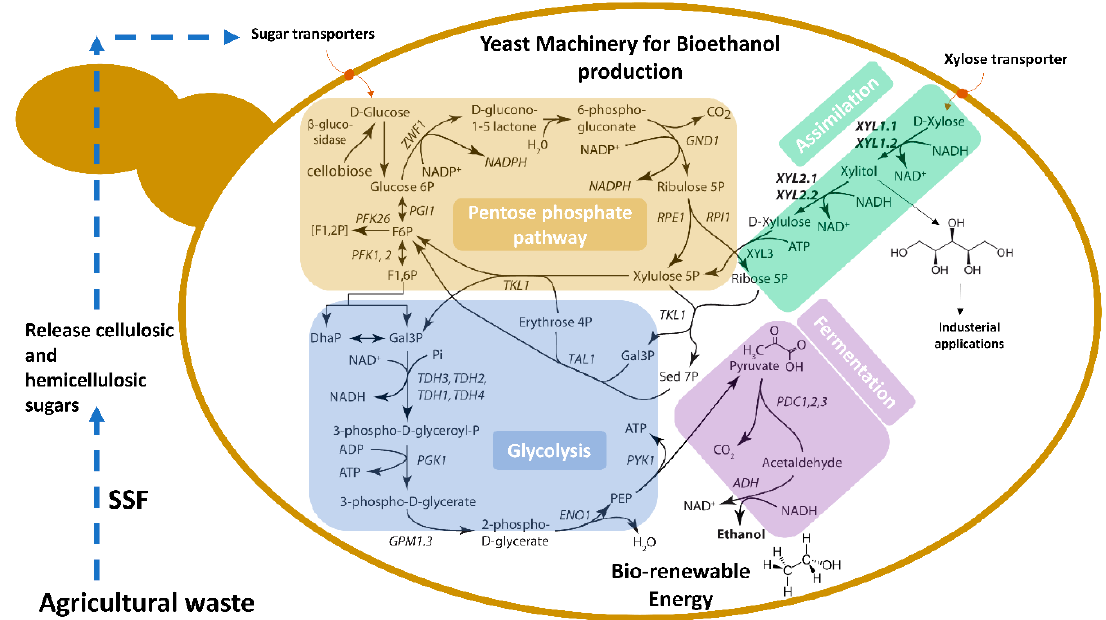
Figure 1. Model of yeast fermentation machinery for bioethanol production using the agriculture waste to feed yeasts [4]. The metabolic pathways for xylose and glucose assimilation and fermentation are indicated including the pentose phosphate pathway and glycolysis. The agriculture waste is treated through the enzymatic and chemical simultaneous saccharification and fermentation (SSF) processes to release the cellulosic and hemicellulosic sugars. The hexose and pentose sugars are transported by specific hexose and pentose sugar transporters into yeast for further metabolizing processes.